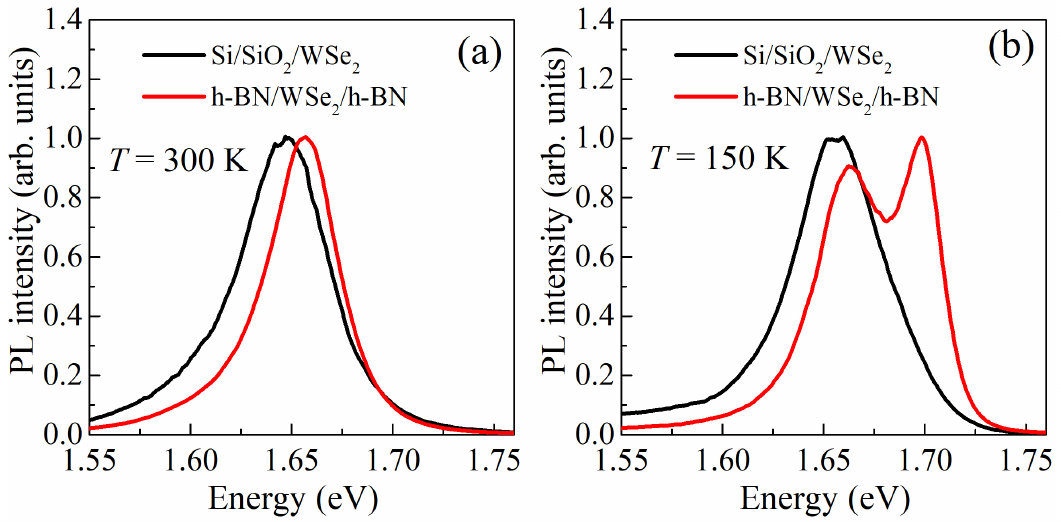
Figure 6. Comparison of the photoluminescence spectra for non-encapsulated and encapsulated WSe 2 monolayers at room ( a ) and low ( b ) temperatures. The spectra are normalized to